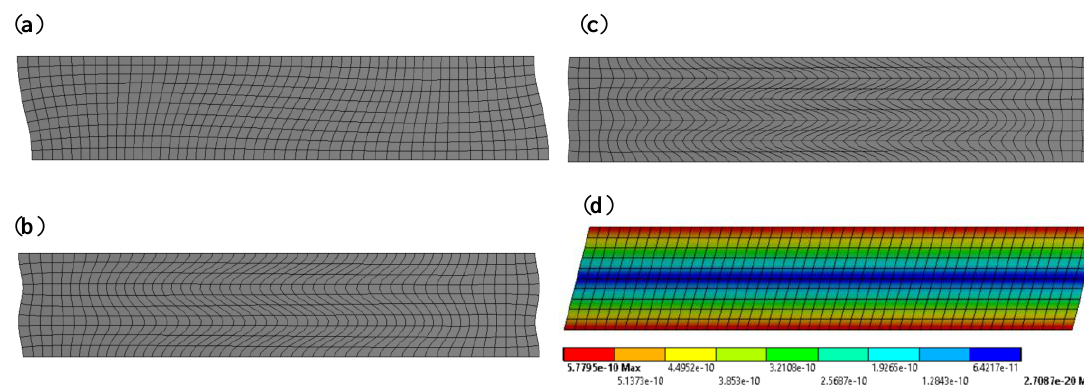
Figure 3. Finite element mode shapes of free d35 PZT element: ( a ) First mode at 853 kHz; ( b ) second mode at 3001 kHz; ( c ) third mode shape at 5051 kHz; ( d ) total deformation (mm) at 30 kHz.